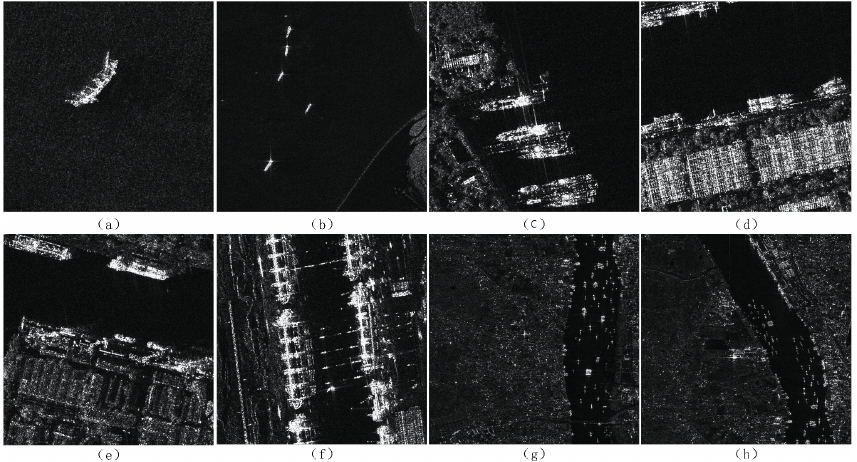
Figure 10. Typical legends in HRSID. ( a ) and ( b ) represent single-ship and multi-ship scenarios in the far sea, respectively; ( c ) and ( d ) for ships arranged in near shore; ( e ) and ( f ) are ships moored in the port; and ( g ) and (h) show small ships clustered in river